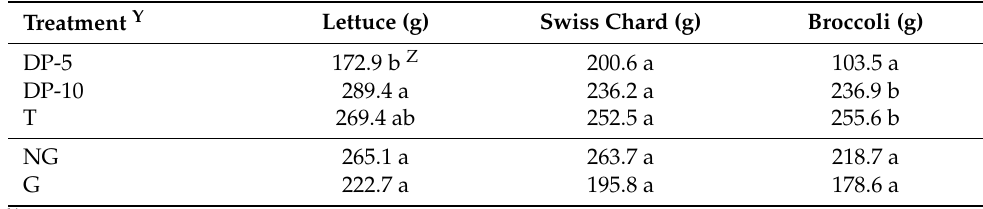
Table 3. Cumulative yield of vegetables grown in a bermudagrass lawn in 2015. Treatment